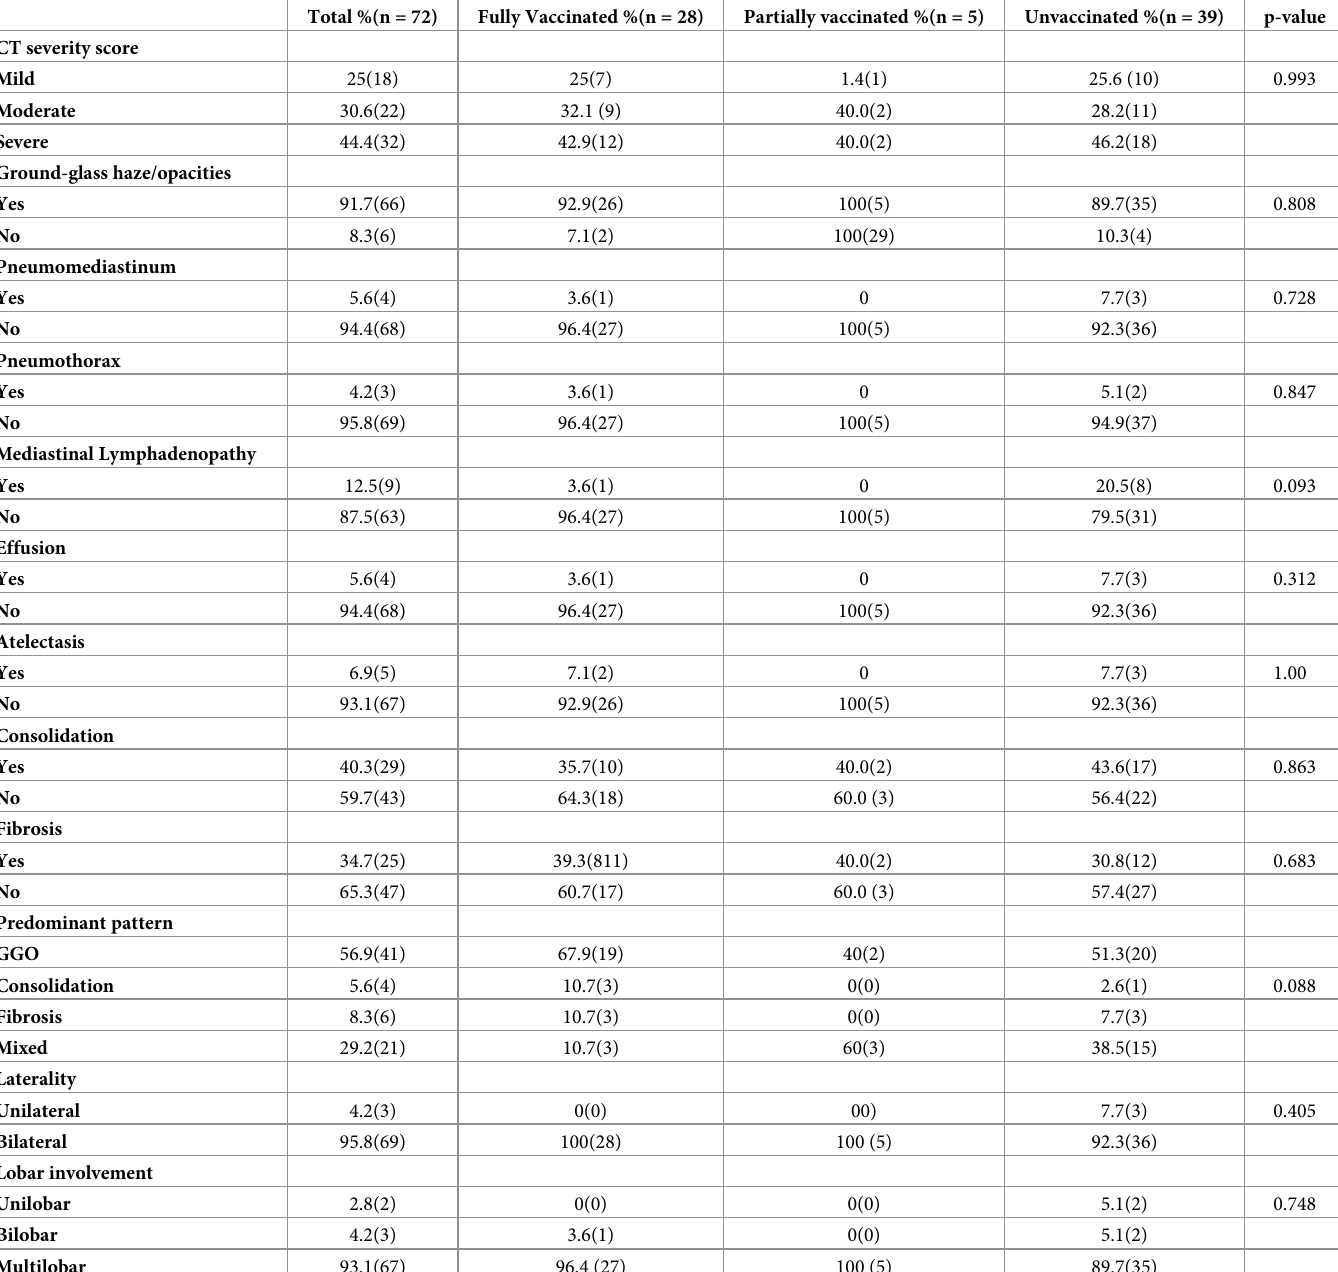
Table 5. Computed tomography chest findings of COVID-19 infection in vaccinated as compared to non-vaccinated patients. Total %(n = 72) Fully Vaccinated %(n = 28) Partially vaccinated %(n =